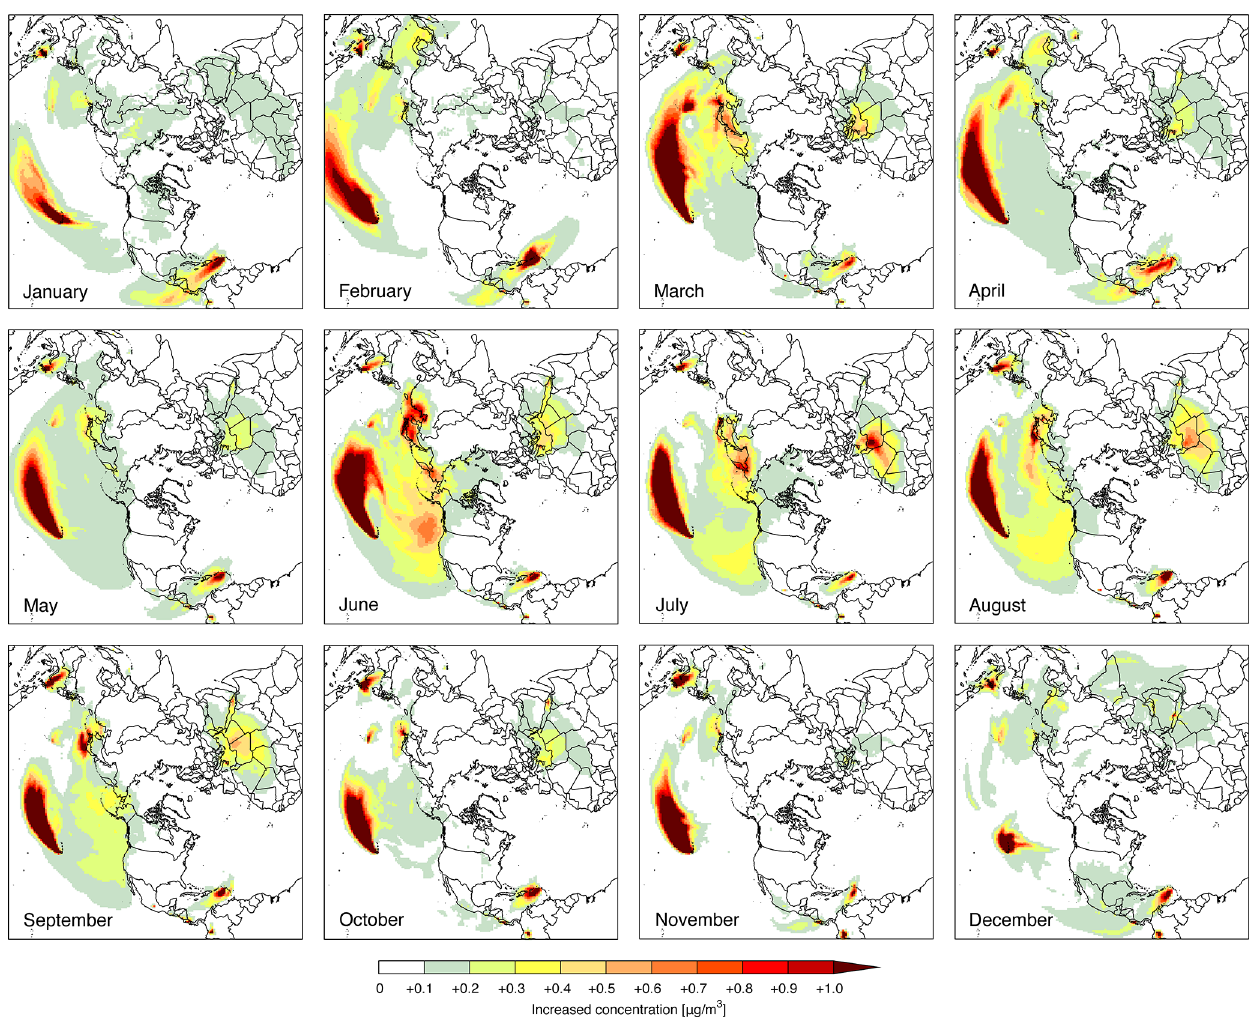
Figure 5. Simulated increased surface SO 2 −